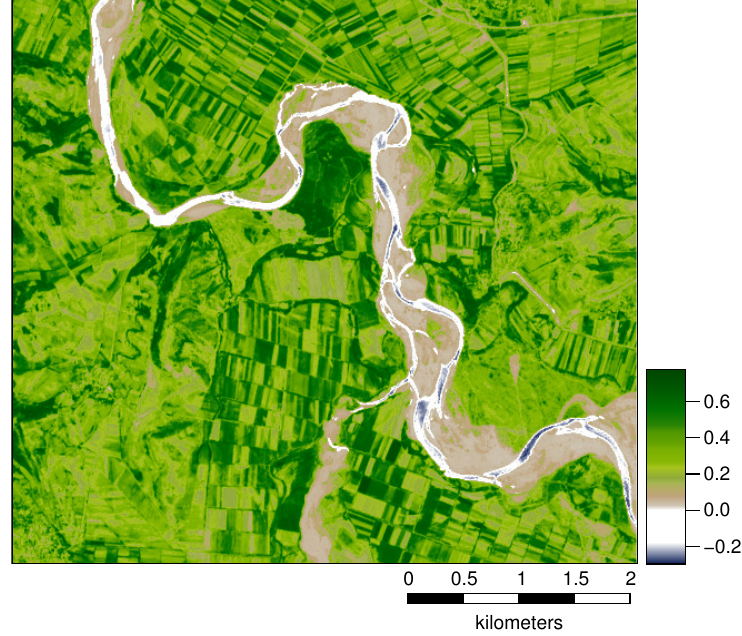
Figure 2. Example of the NDVI map of the Vjosë River, Sentinel-2